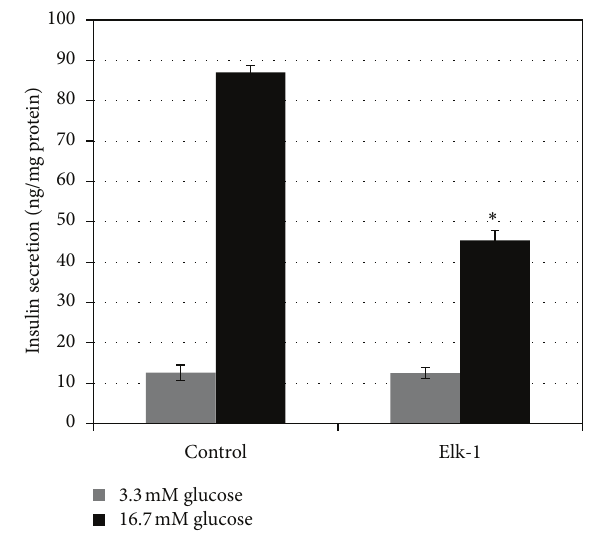
Figure 5: Elk-1 inhibited glucose-stimulated insulin secretion in INS-1 cells. INS-1 cells were transfected with Elk-1 expression plasmid pCMV3.0b-Elk-1 or empty vector pCMV3.0b as control for 48 h. Control cells demonstrated a 6.9-fold increase in insulin secre- tion with 16.7mM glucose, whereas Elk-1 overexpressing cells had only a 3.6-fold increase. Elk-1 overexpressing group demonstrated a decrease of GSIS to 52% of the control value. Each experiment was done in triplicate and repeated three times. ∗ 𝑃 < 0.001 versus